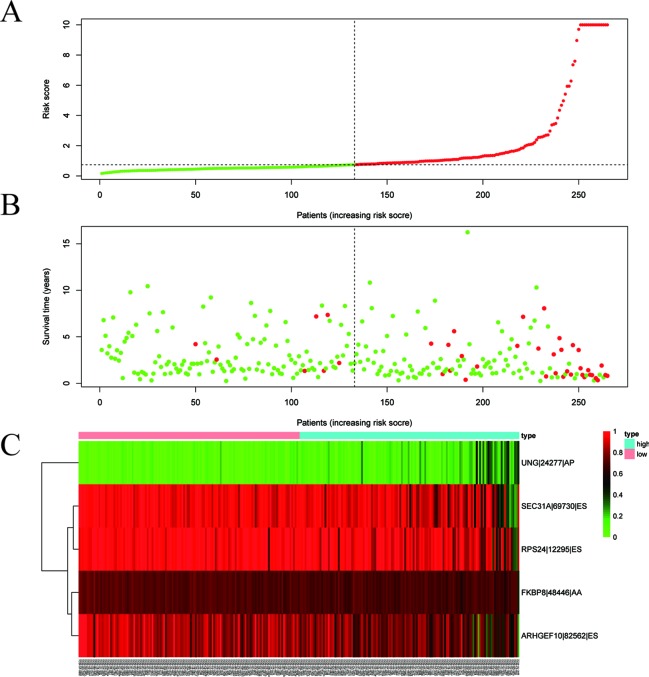
Development of the prognostic index. Risk plot of ALL alternative splicing (AS) event. (A) Rank of prognostic index and distribution of groups. Patients with papillary renal cell carcinoma (pRCC) were divided into low- and high-risk subgroups based on the median value of the risk score calculated. (B) The survival status and survival time of patients with pRCC ranked by risk score. In (A) and (B), green dots represent for patients with a low level of risk score and red dots represent for patients with a high level of risk score. (C) Heatmap of included AS event in ALL. Patients were divided into two groups according to risk score. The color from green to red means the Percent Spliced In (PSI) value from 0 to 1.